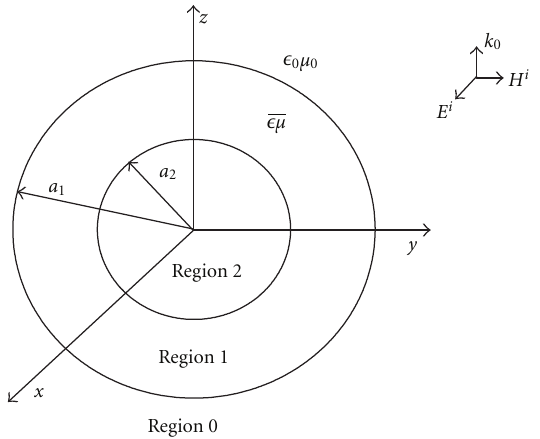
Figure 1: Geometry of a plane wave scattering by a plasma anisotropic spherical